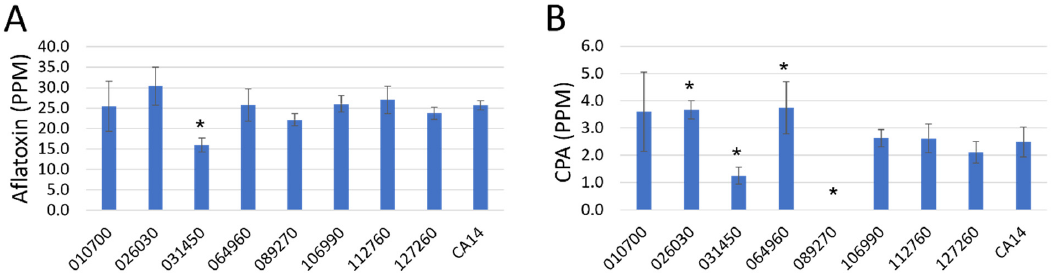
Figure 4. Aflatoxin ( A ) and cyclopiazonic acid (CPA) ( B ) levels present in maize kernels after 7 days of infection with the indicated transcription factor knockout strains. Error bars represent the standard deviation. Asterisks (*) represent different LS means from CA14 at α < 0.05.